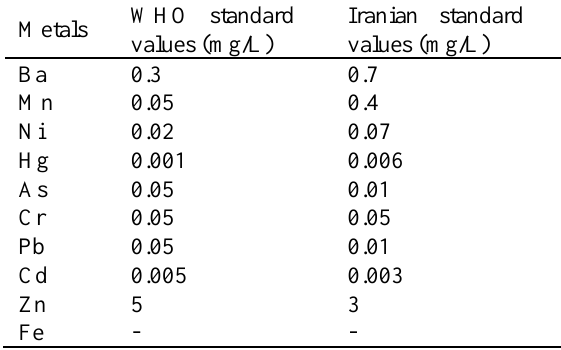
Table 1. Permissible concentration of toxic elements in